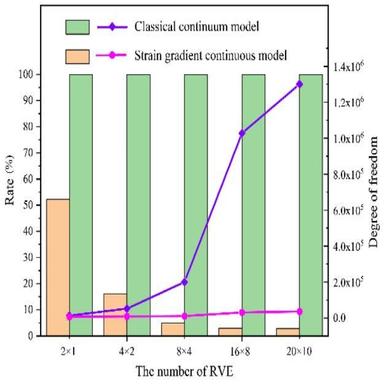
Two methods are used to calculate the variation trend of degrees of freedom.